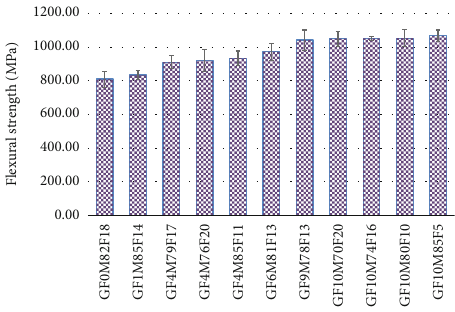
Figure 13: The maximum of the average fl exural strength of